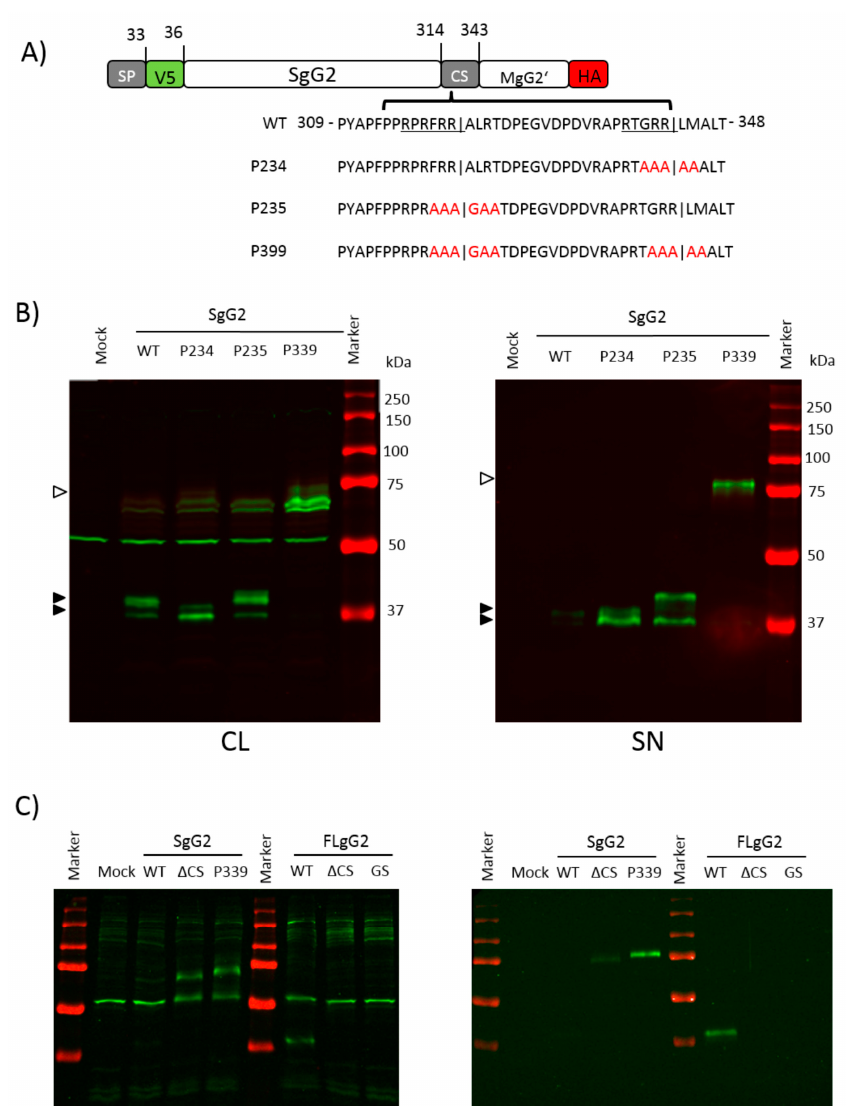
Figure 6. Mutation of residues flanking both proposed cleavage sites abrogates cleavage. ( A ) Schematic representation of the mutations introduced into the CS sequence. The wild type CS sequence (amino acids 314–343) and mutated residues (in red) are shown. Underlined residues indicate potential furin motifs; vertical lines in sequence indicate proposed cleavage. ( B ) Western blots showing detection of gG2 proteins in the cell lysate (CL, left blot) and supernatant (SN, right blot) of HEK-293T cells transfected with wild type (WT) SgG2 or mutant constructs. The proteins were detected with anti-V5 (green) and HA (red) antibodies. Black arrowhead indicates SgG2 cleavage products, and white arrowheads indicate precursor protein. One of four independent experiments is shown. ( C ) Western blots showing detection of gG2 proteins in the cell lysate (CL, left blot) and supernatant (SN, right blot) of ARPE19 cells transfected with wild type (WT) SgG2/FLgG2 or mutated